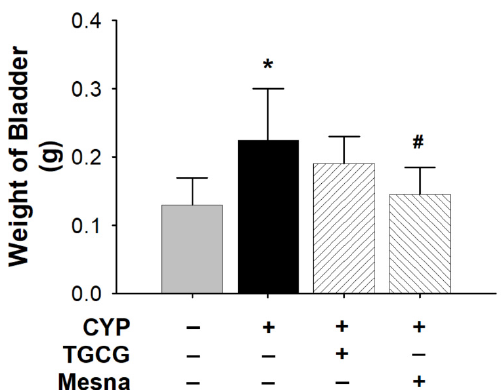
Figure 2. Average weight of bladders between group 1—saline-injected control, group 2—CYP + placebo with normal saline, group 3—CYP + TGCG (200 mg/kg), and group 4—CYP + Mesna (30 mg/kg). Each bar in the figure denotes the mean ± standard deviation. * p < 0.05 contrasted to control group. # p < 0.05 compared to CYP.